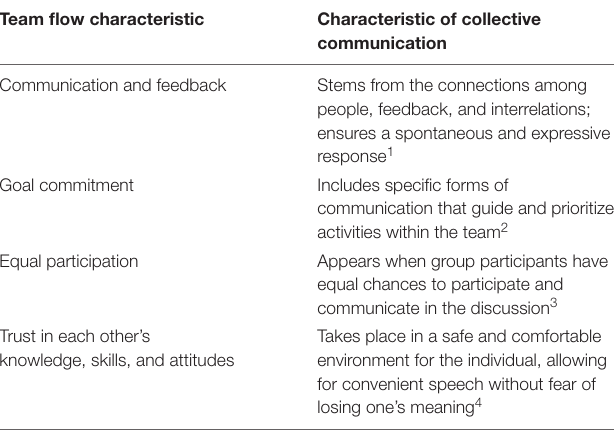
TABLE 3 | Overlaps between collective communication and team flow. Team flow